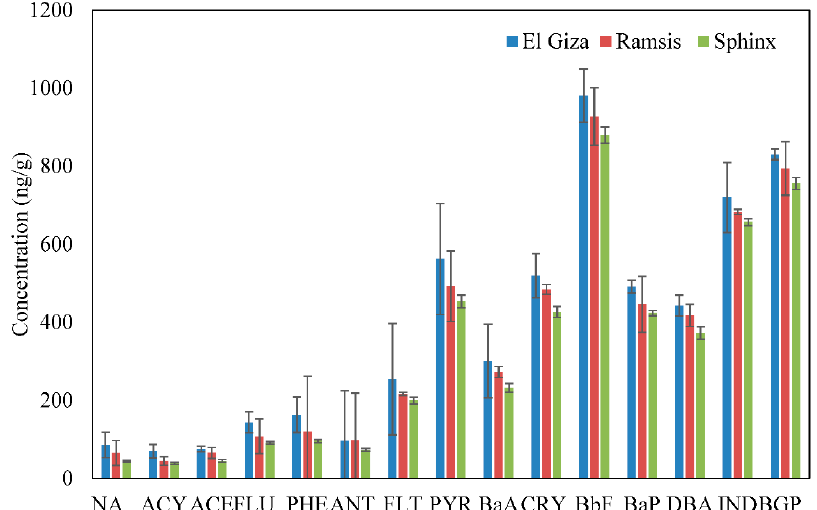
Figure 2. Comparison of the concentrations of each individual polycyclic aromatic hydrocarbon (PAH) compound in total suspended particulate matter collected from El Giza, Ramsis, and Sphinx Square.